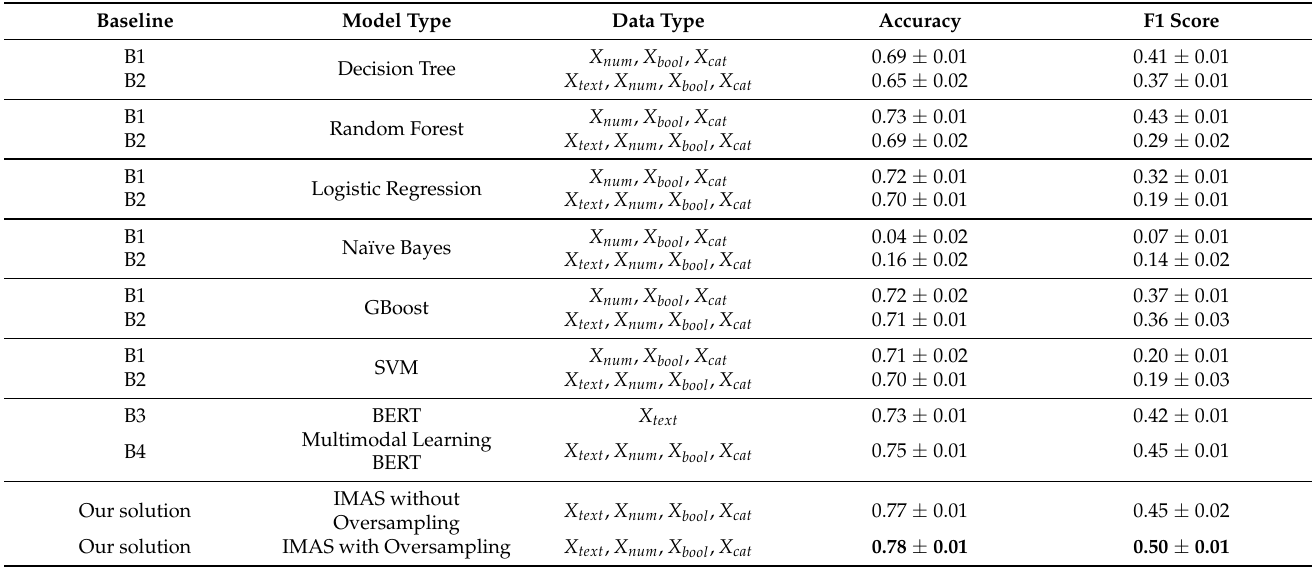
Table 4. Accuracy and F1 results of our baselines and two variants of the proposed IMAS method (with and without